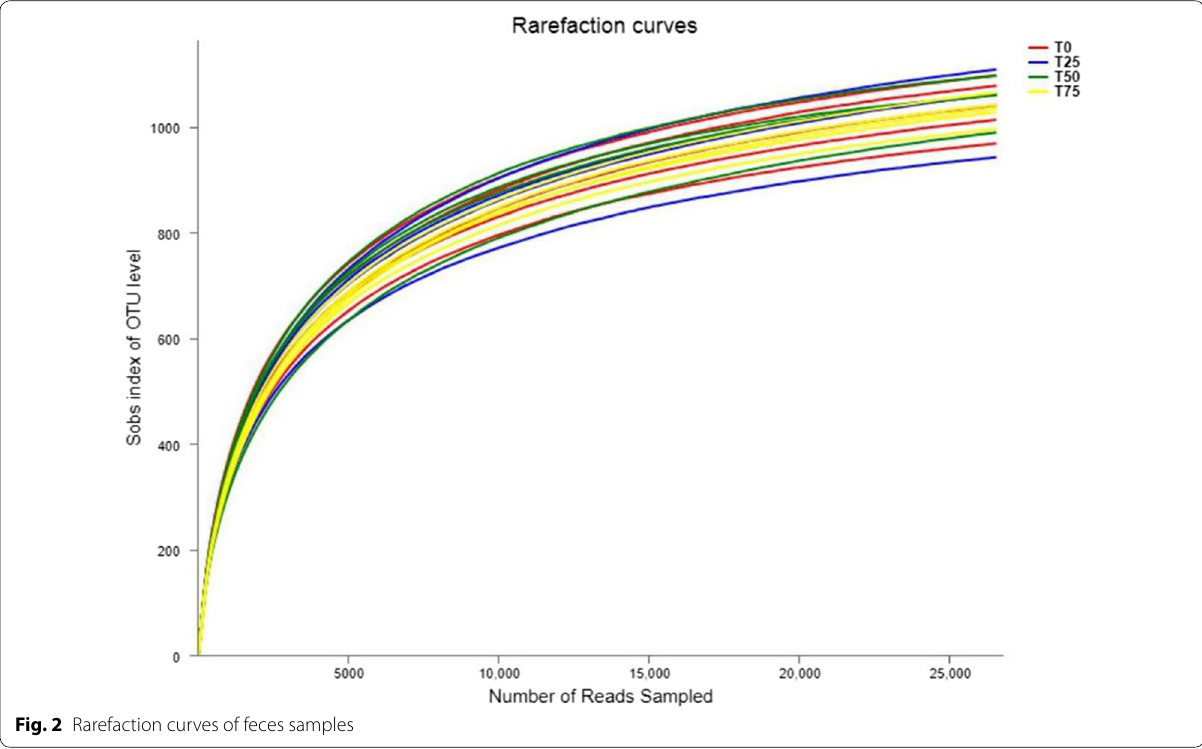
Fig. 2 Rarefaction curves of feces samples